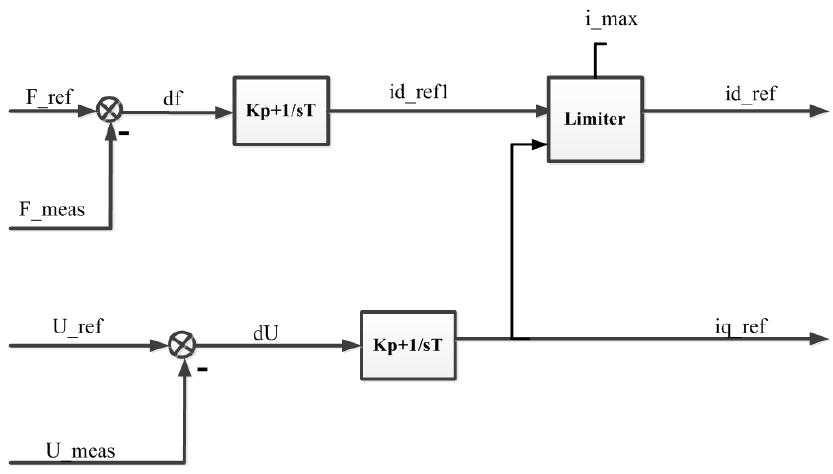
Figure 3. The block diagram of the voltage-frequency (VF) controller for BESS1 [23].